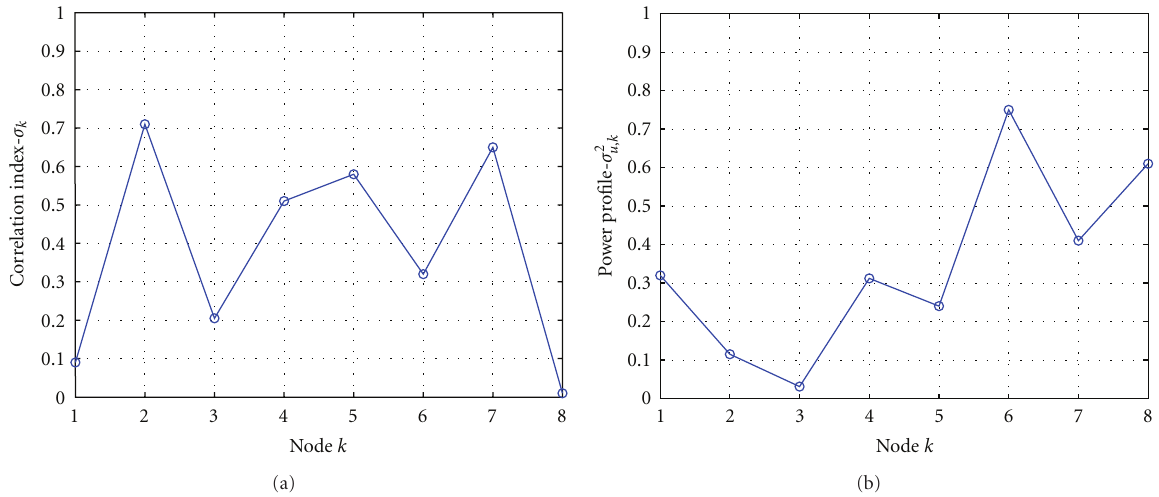
Figure 2: Network statistics used for the simulation of BDLMS. (a) Network corelation index per node. (b) Regressor power profile.